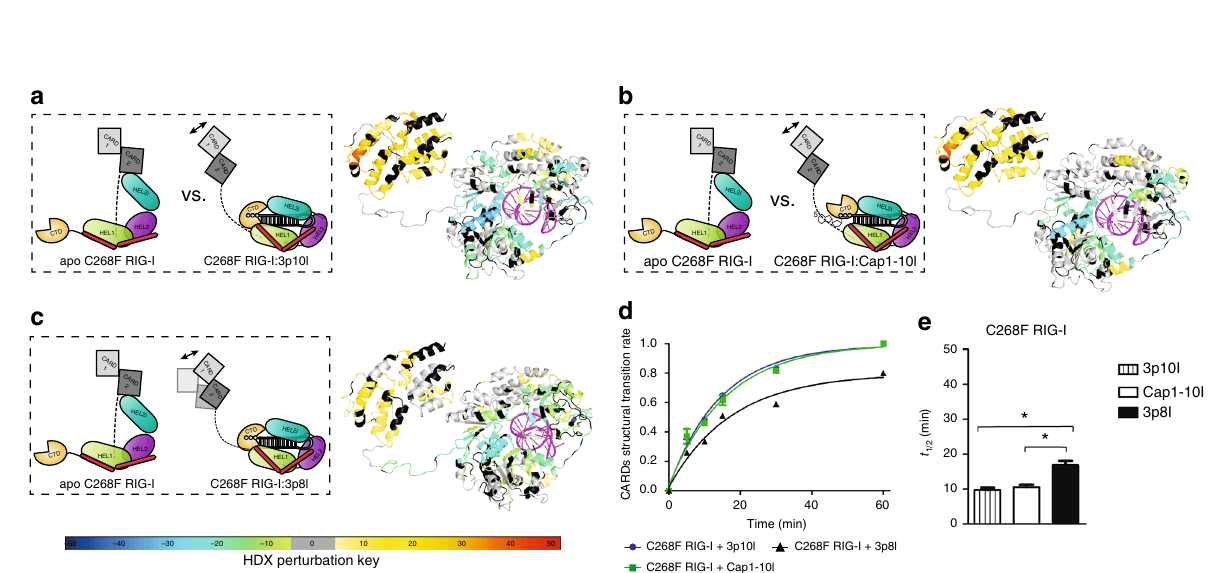
Fig. 3 E373A affects RIG-I proofreading in an ATP-dependent manner. a MS spectra of WT and E373A RIG-I CARD2 latch peptide Y103 – 114 derived from indicated complexes in indicated on-exchange time points. The abundance of each mass population (high and low) is determined as Fig. 2a. b , c In each indicated state, the fraction of E373A ( b ) or WT ( c ) RIG-I CARDs molecules in the higher MS population (open conformation) to the total population is plotted against the on-exchange time points as Fig. 2c. d , e Half-life ( t 1/2 ) of respective partial opening event is determined by fi tting an exponential curve as Fig. 2d. (*Means that Cap1-10l-treated E373A RIG-I (20.51 min) and 3p10l-treated E373A RIG-I predicted t 1/2 (72.7 min) was higher than the upper limit (58.44 and 16.95, respectively, α = 0.05), whereas t 1/2 calculated 3p10l- and ATP-treated E373A RIG-I (12.11 min) exceeded lower limit (13.33, α = 0.05). Cap1-10l- and ATP-treated E373A did not exceed the lower or upper limits in this comparison. NS means statistically nonsigni fi cant between compared groups. t 1/2 calculated for Cap1-10l-bound WT RIG-I and Cap1-10l- and ATP-treated WT RIG-I did not exceed the lower or upper limits ( α = 0.05) in this comparison.) f , g Differential deuterium uptake plots of CTD capping loop peptide region (VSRPHPKPKQFSSF, + 3) of E373A ( f ) or WT RIG-I ( g ) upon receptor perturbed by 3p10l or Cap1-10l RNA in the presence or absence of ATP. The data are plotted as percent deuterium uptake vs. time on a logarithmic scale. The HDX plots of this CTD capping loop peptide between indicated groups were statistically analyzed by HDX Workbench (Supplementary Fig. 1c) 41 . h , i Schematic representations of CTD capping loop conformation associated with E373A ( h ) and WT RIG-I ( i ) upon the receptor interaction with ATP in the presence of Cap1-10l and 3p10l RNAs